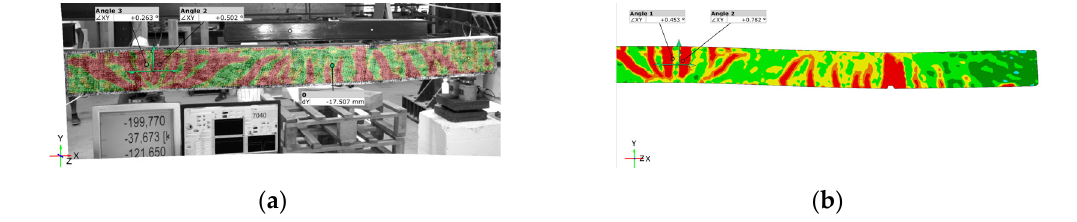
Figure 20. Rotations of bottom sections at the time of failure: ( a ) Beam No. 1, ( b ) Beam No. 2.